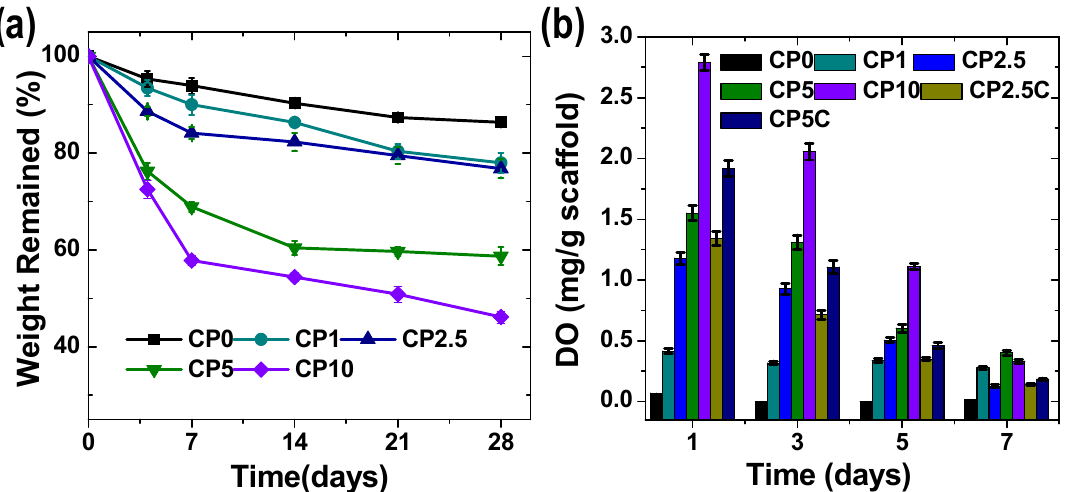
Figure 4. ( a ) Degradation profiles in PBS buffer, and ( b ) oxygen ‐ releasing kinetics of the composite PGS/PCL scaffolds at various CP concentrations.